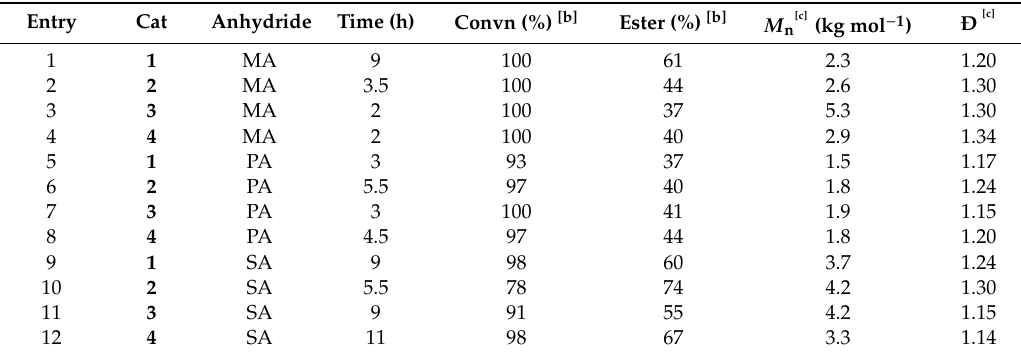
Table 3. ROCOP of CHO with di ff erent cyclic anhydrides [a] .